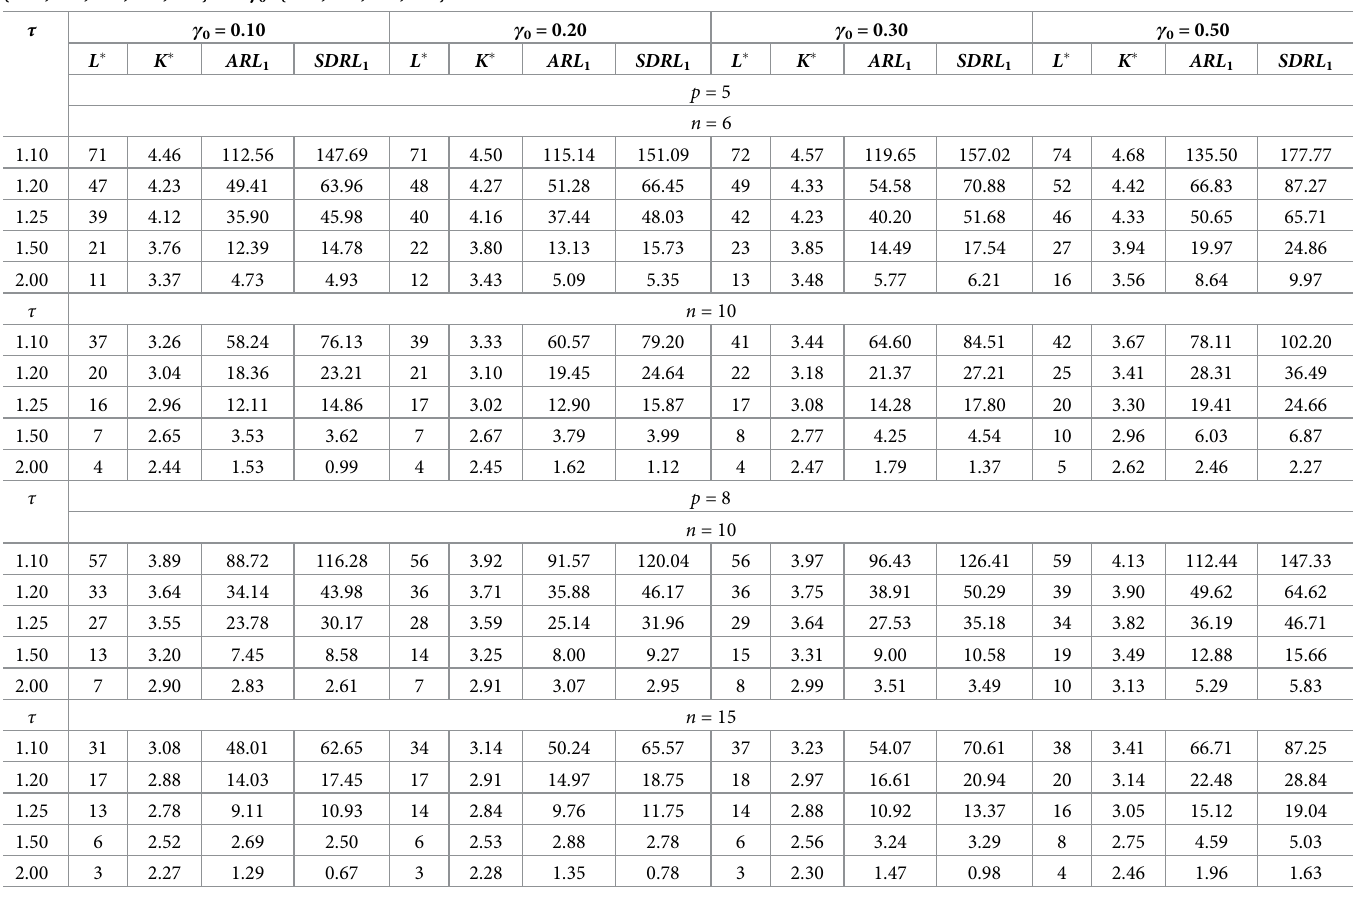
Table 3. Optimal charting parameters and the corresponding ARL1 and SDRL1 values of the multivariate SS chart for p 2 {5,8}, n 2 {6,10,15}, τ 2 {0.10,1.20,1.25,1.50,2.00} and γ